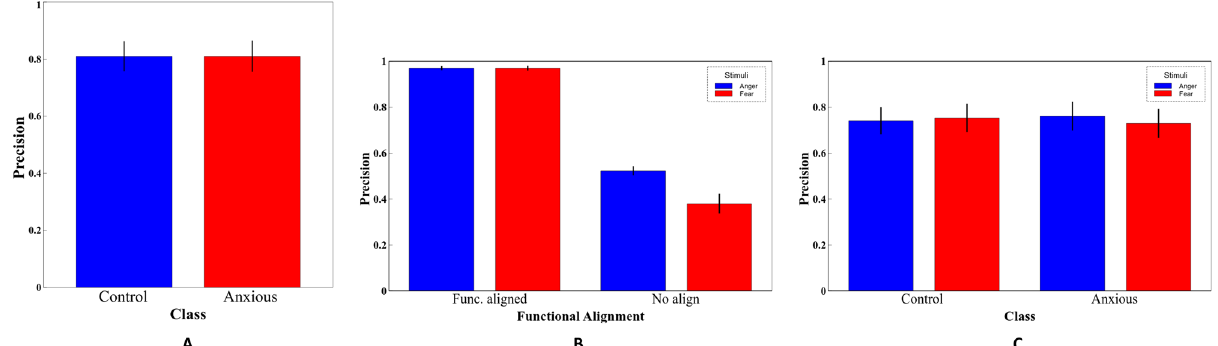
Figure 7. Precision tables for both anxious versus non-anxious and negative stimuli classification analysis. ( A ) Precision table for anxious versus non-anxious AdaBoost classification model. ( B ) Precision table for fearful versus angry faces, linear SVM with and without functional alignment. ( C ) Precision table for four- class classification model of negative stimuli and disease state. All error bars represent the standard error of the precision across outer-CV